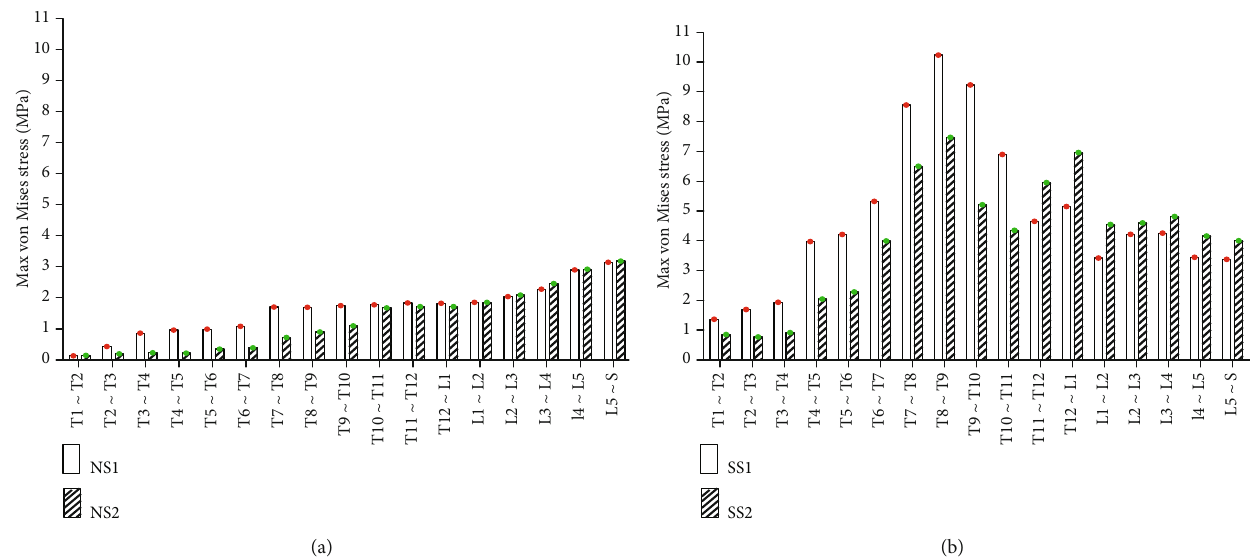
Figure 9: Stress distribution of disc in four spinal models with anterior tilt: (a) stress distribution of normal spinal intervertebral discs; (b) stress distribution of scoliotic spinal intervertebral discs. NS1, NS2, SS1, and SS2 need to be de fi ned here.